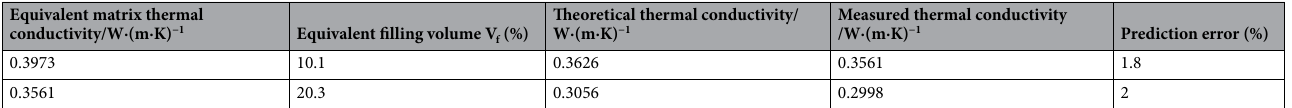
Table 7. Evaluation of thermal conductivity model for multicomponent composites.